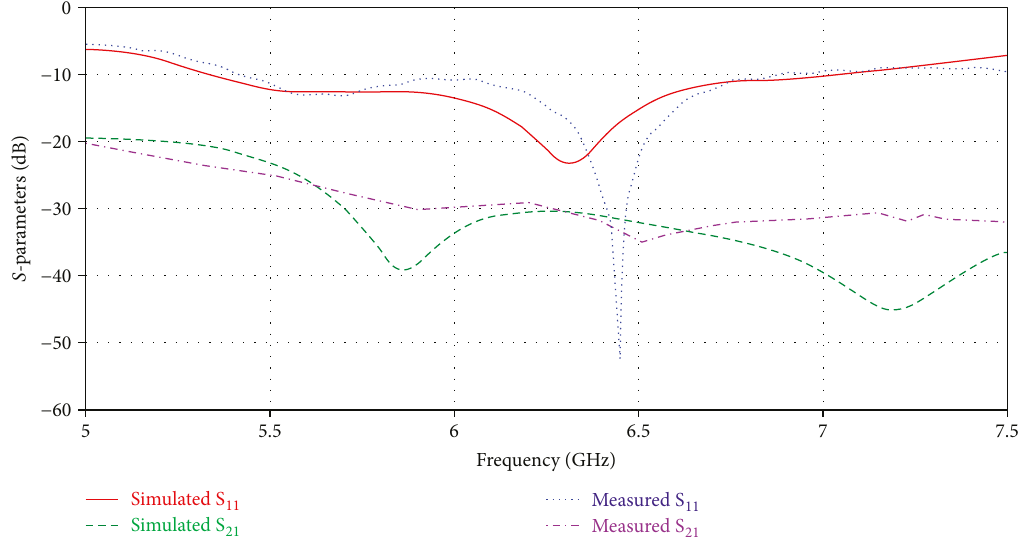
Figure 18: Comparison of the simulated and measured S -parameters with the CSR structure of the proposed MIMO system.